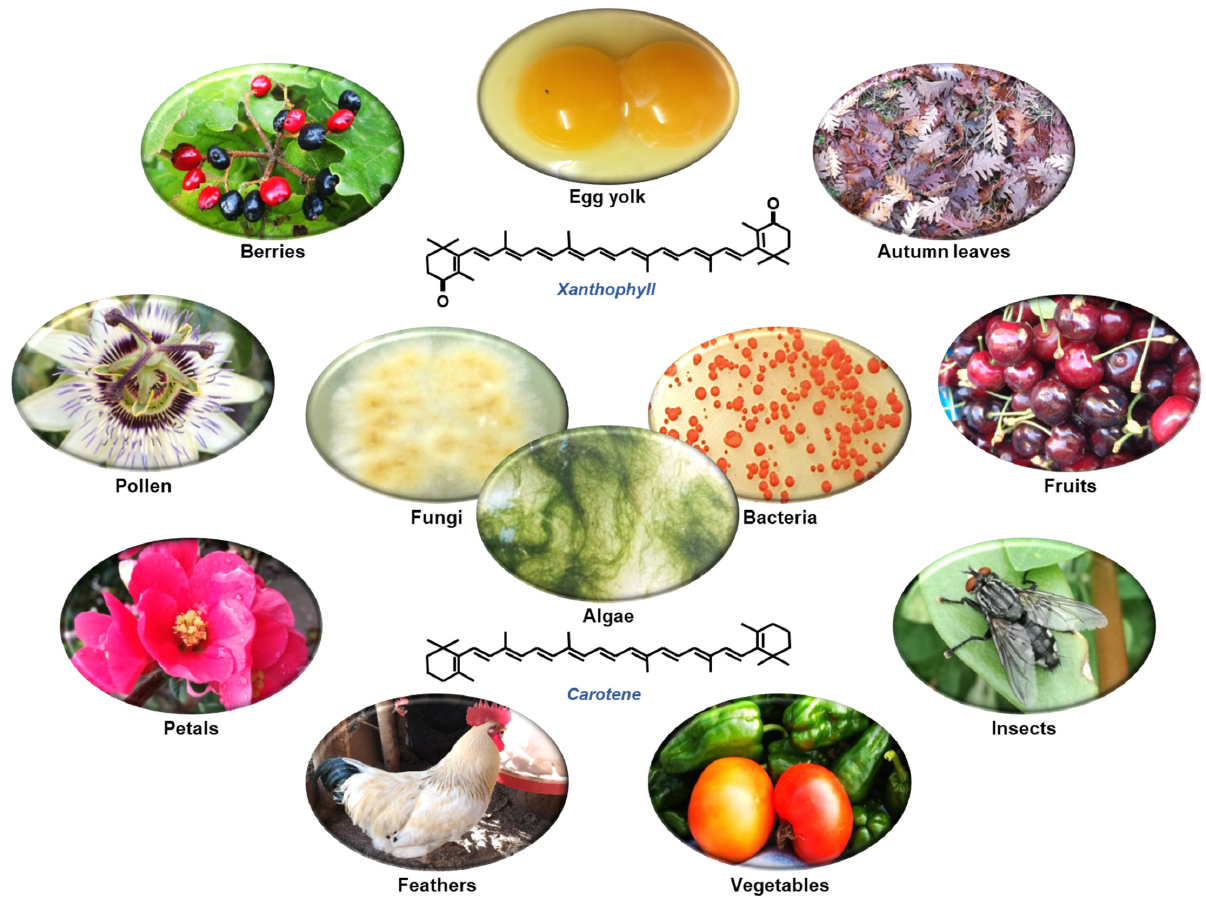
Figure 1. Examples of different colored structures from natural environments where diverse carotenoids can be found. The center panel presents some of the most common carotenoid producers (fungi, algae, and bacteria) and the structure of a xanthophyll (upper: canthaxanthin) and a carotene (lower: β -carotene).